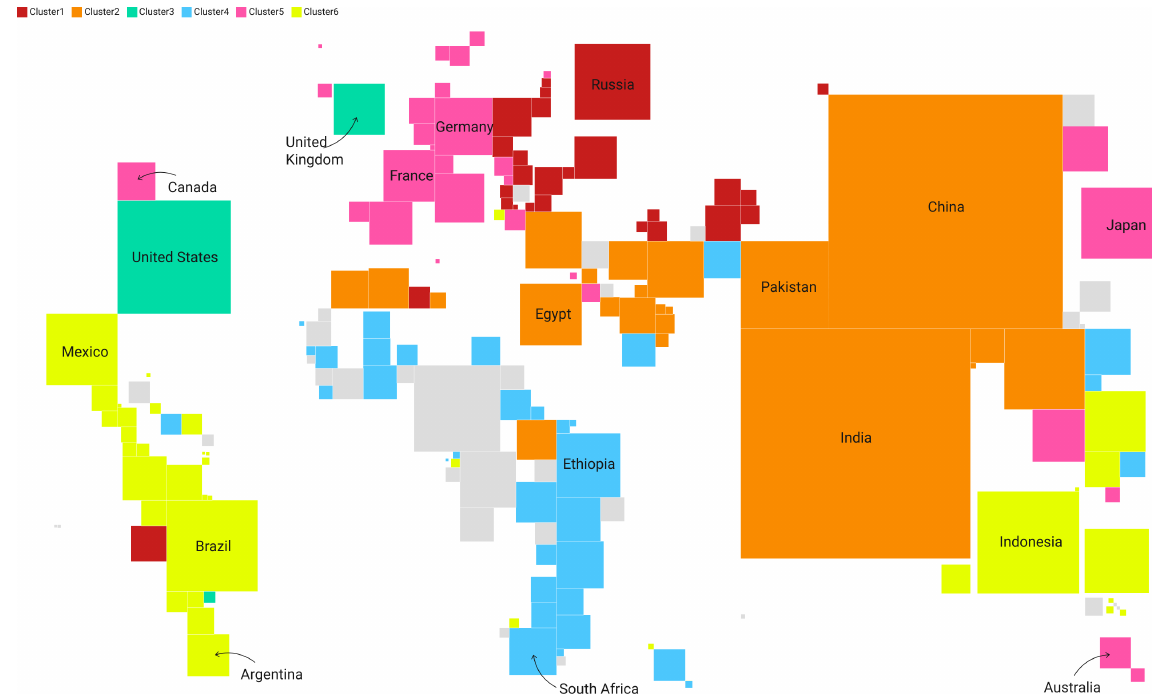
Fig. 10 Geographic clustering characteristics of COVID-19. The countries with the same color are one cluster, and the data of some countries in light gray are missing. The bigger the country or region’s population, the bigger the